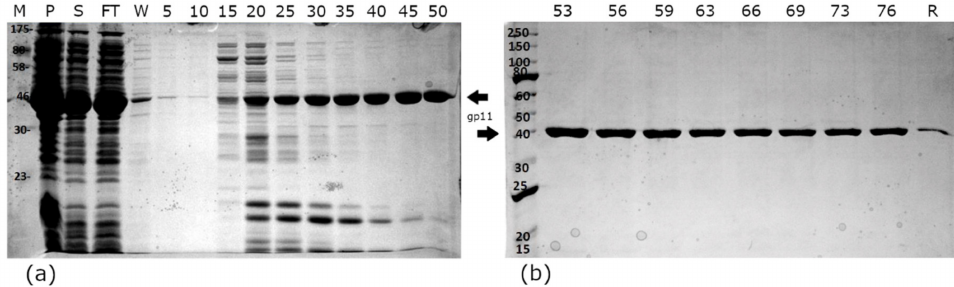
Figure 1. Metal-affinity purification of the gp11 protein from cell lysate. SDS-PAGE gels show the early- ( a ) and late- ( b ) eluting fractions. Although the late-eluting fractions appeared to contain a single species, size-exclusion chromatography was used as a second purification step to increase the purity. Column labels: M—molecular weight standard; P—pellet (insoluble material from cell lysis); S—soluble material from cell lysis; FT—flow through from Talon resin binding, showing a protein that did not bind to the resin; W—10 mL wash of resin. Numbering references the fractions eluted from the column: 5 µ L of cell lysate fractions (P, S, FT) and 10 µ L of each fraction was loaded in each lane; R—residual protein remaining bound to the Talon resin, determined by mixing SDS dye with 10 µ L of suspended resin.